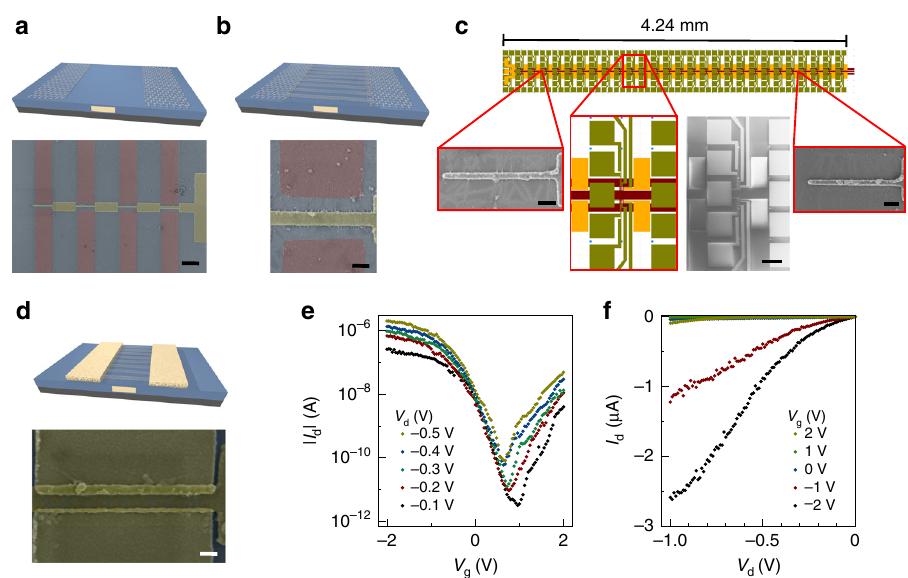
Fig. 5 Large-scale device integration and scaling with graphene-based, electric- fi eld-assisted nanomaterial placement. a Artistic rendering of a Si/SiO 2 substrate with embedded metal electrode and a patterned graphene layer for fi eld-assisted carbon nanotube placement. The scanning electron microscope (SEM) false color image reveals how the graphene layer (red) is patterned to form gaps at the position of the embedded metal electrode (yellow) for facilitating the nanotube placement. Scale bar: 1 µ m. b Artistic rendering and SEM false color image of the carbon nanotube placement across the embedded metal electrode (yellow), at the substrate surface, before the graphene electrodes are removed (red). Deposition conditions are V DEP = 3 V, f = 1 MHz, t = 5 min. Scale bar: 200 nm. c Layout of large-scale integration based on the device architecture in a – f . The insets display SEM images of individual devices taken at representative locations of a mm-scale assembly structure, as well as an SEM image of a larger set of individually addressable devices. Scale bars (from left to right): 200 nm, 50 µ m, and 200 nm. d Artistic rendering and SEM false color image (top view) showing fi nal carbon nanotube array transistor, after removal of graphene layer and manufacturing of metal contacts. Scale bar: 100 nm. e Electrical transfer characteristics of a carbon nanotube array transistor. f Electrical output characteristics of a carbon nanotube array